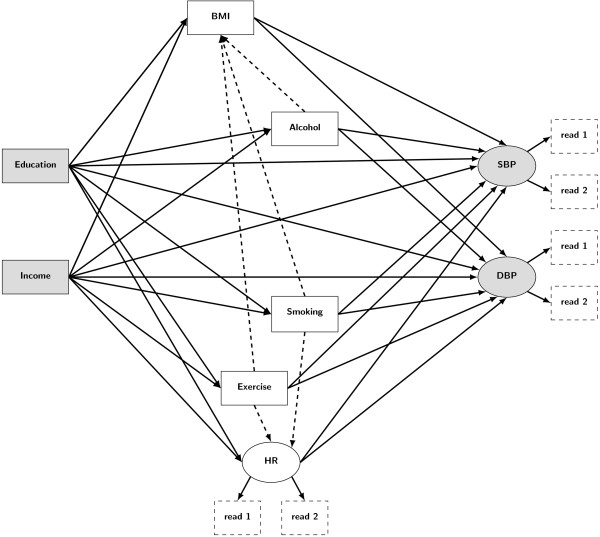
Hypothesised causal pathways between education, income and blood pressure. Squares and circles represent observed and latent variables, respectively. Arrows indicate hypothesised causal effects. Dashed squares indicate each of the multiple readings from which the values of the latent variables systolic blood pressure (SBP), diastolic blood pressure (DBP) and resting heart rate (HR) are inferred. Race, age and use of antihypertensive medication are omitted from the diagram, but taken into account as possible confounders in the model.